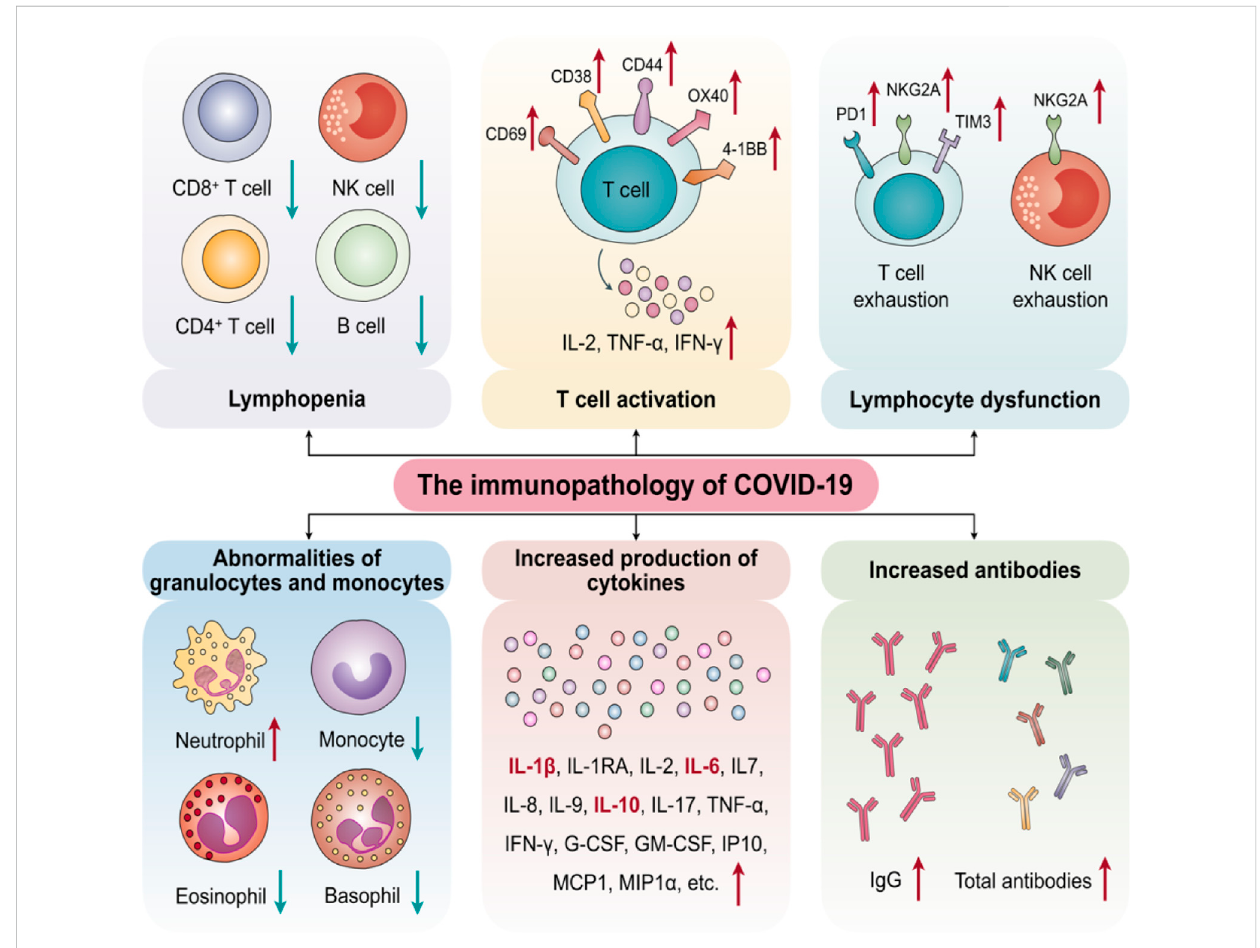
FIGURE 4 The key of Cytokine Storms to determine SARS/COVID-19 in immunopathology (Adapted from Yang et al.,